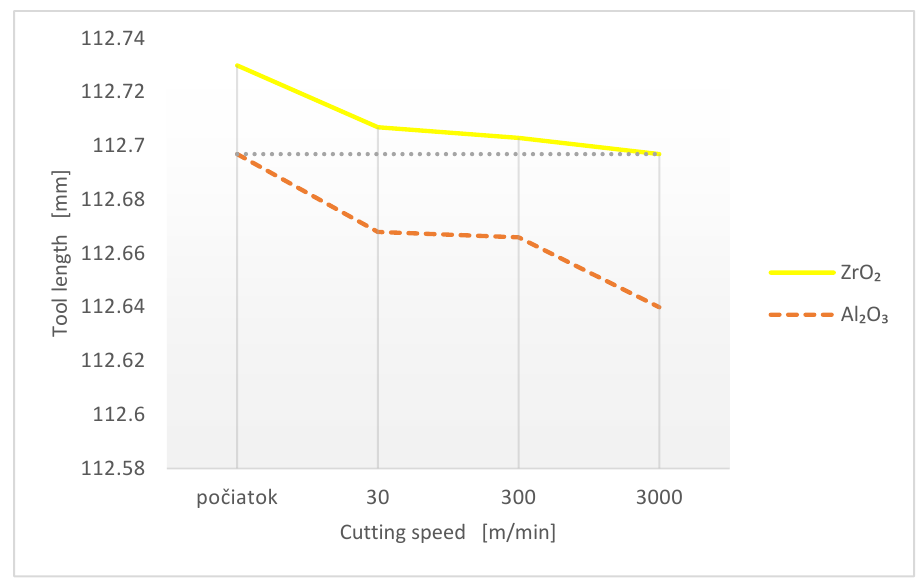
Figure 6. Influence of cutting speed on dimensional tool wear.